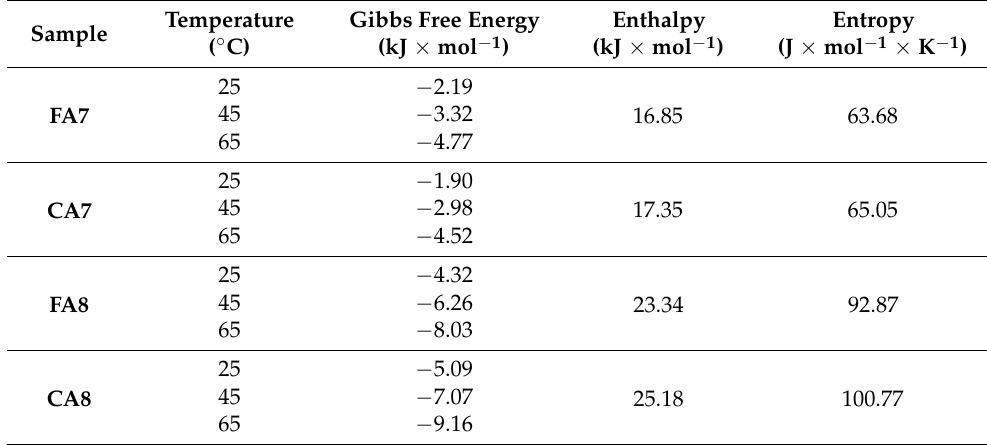
Table 6. Thermodynamic parameters.